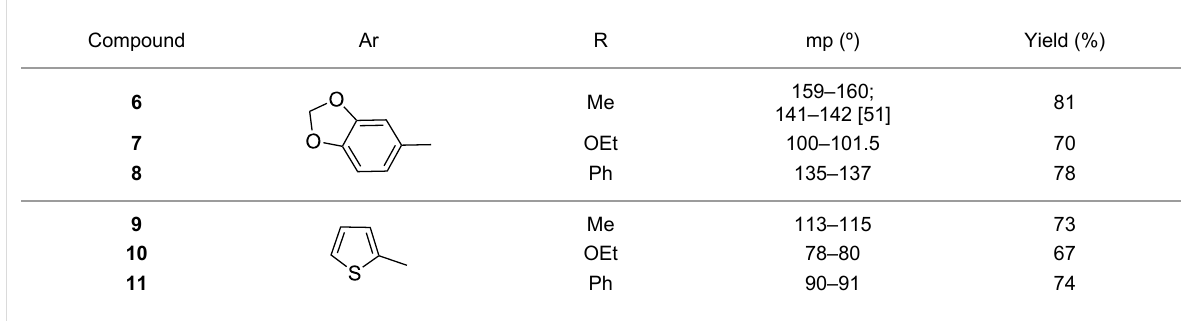
Table 1: Reported 3,5-disubstituted